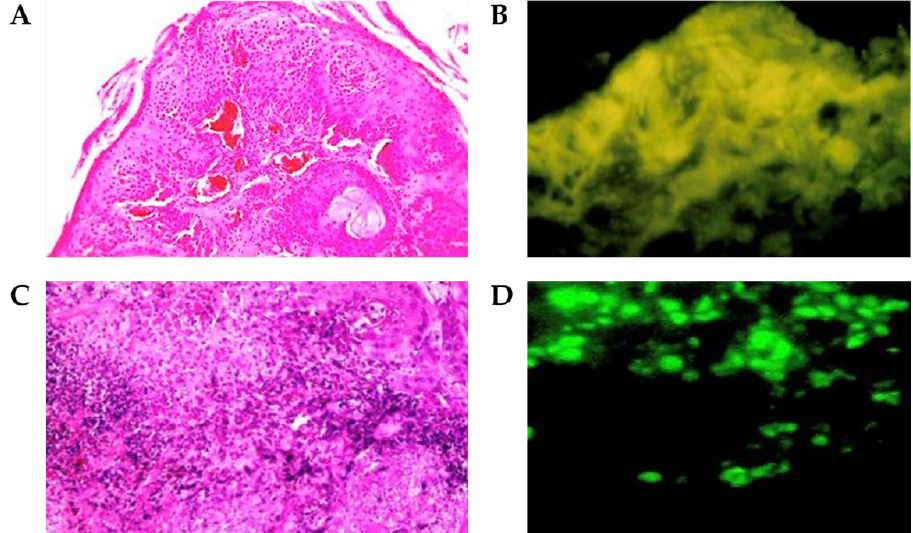
Figure 3. An example of stimulated squamous cell carcinoma on the buccal mucosa in image of OCT concept ( A ), under white light ( B ), and 3 h after intravenous application of Photofrin ® during PDT of tumor ( C ); the tumor area is marked with the symbol (*).